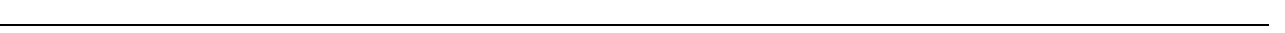
Fig. 4 Fxr1 promotes cell proliferation and inhibits senescence-induced by ectopic Fbxo4 expression. a Fxr1 knockdown reverses Fbxo4 knockdown-induced cell proliferation of 74B cells. b Western blot shows Fbxo4 and/or Fxr1 Knockdown in 74B cells. Empty triangle indicates nonspeci fi c band. c Expression of p21 and p27 in 74B cells upon Fbxo4 overexpression, Fxr1 knockdown and both Fbxo4 and Fxr1 overexpression. d β -Gal staining indicates senescent cells in 74B cells upon Fbxo4 overexpression, Fxr1 knockdown and both Fbxo4 and Fxr1 overexpression. The numbers show the percentage of β -Gal-positive cells in three independent experiments. e , f p21 and p27 knockdown rescue senescence in Fxr1 knockdown ( e ) and Fbxo4 overexpressing ( f ) 74B cells. The numbers show the percentage of β -Gal-positive cells in three independent experiments. g , i p21 and p27 knockdown rescues cell proliferation in Fxr1 knockdown ( g ) and Fbxo4 overexpressing ( i ) 74B cells. h , j Western blots show the knockdown of p21 and p27 in Fxr1 knockdown ( h ) and Fbxo4 overexpressing ( j ) 74B cells. Empty triangle indicates nonspeci fi c band. All the data represent mean ± s.d. and were analysed by Two-way ANOVA, followed by Fisher ’ s LSD as post hoc test ( n = 3). * p < 0.05; ** p < 0.01. Scale bar, 10 μ